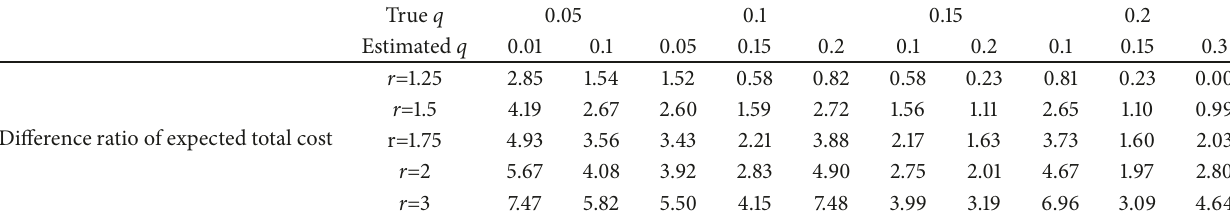
Table 6: The different ratio of expected total cost caused by estimation error of q (%).